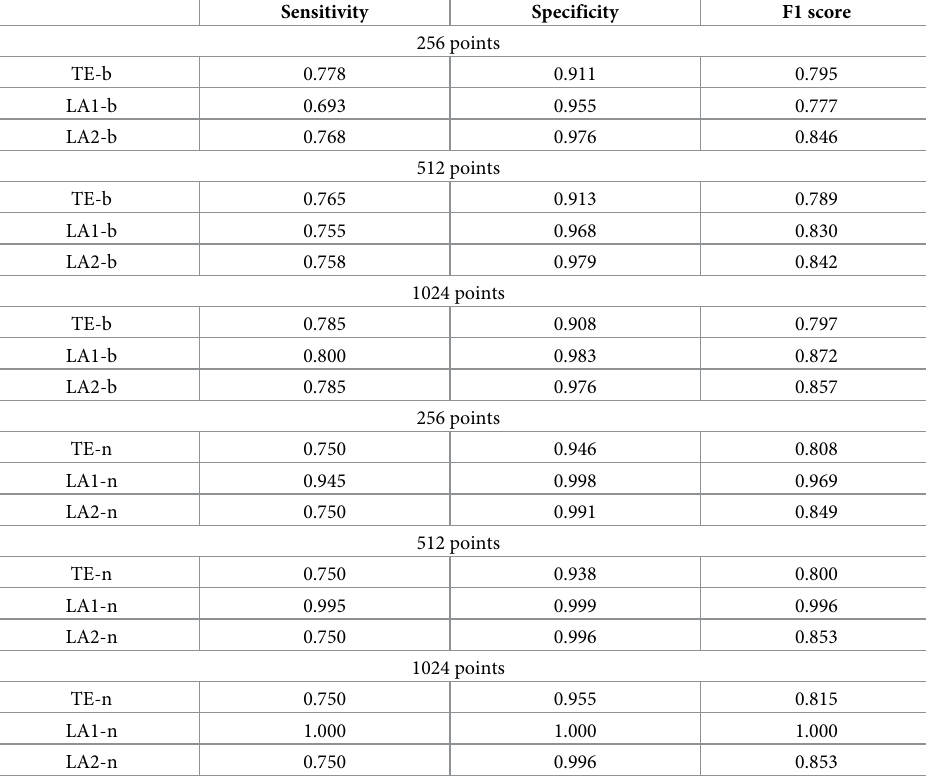
Table 3. Sensitivity, specificity and F1 score values obtained from Model C by binning(-b) and NN(-n)